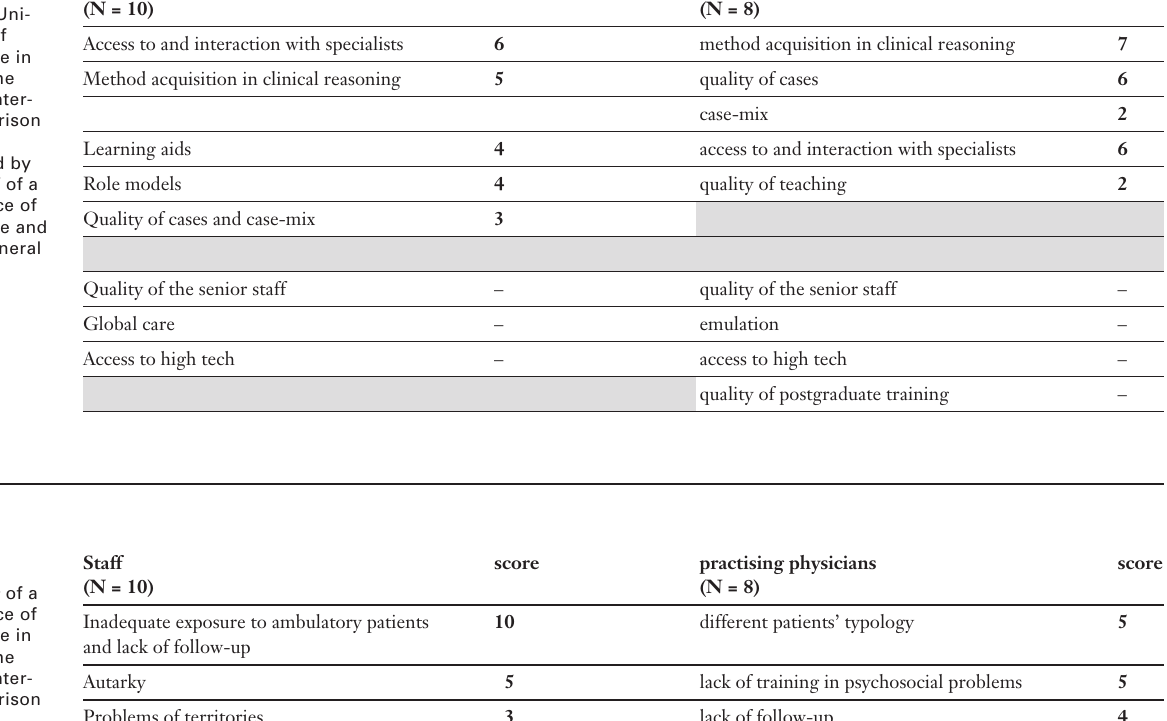
The weaknesses of a University service of Internal Medicine in the training of the future general inter- nist, and comparison of their priority scores, as judged by the present staff of a University service of Internal Medicine and by practising general